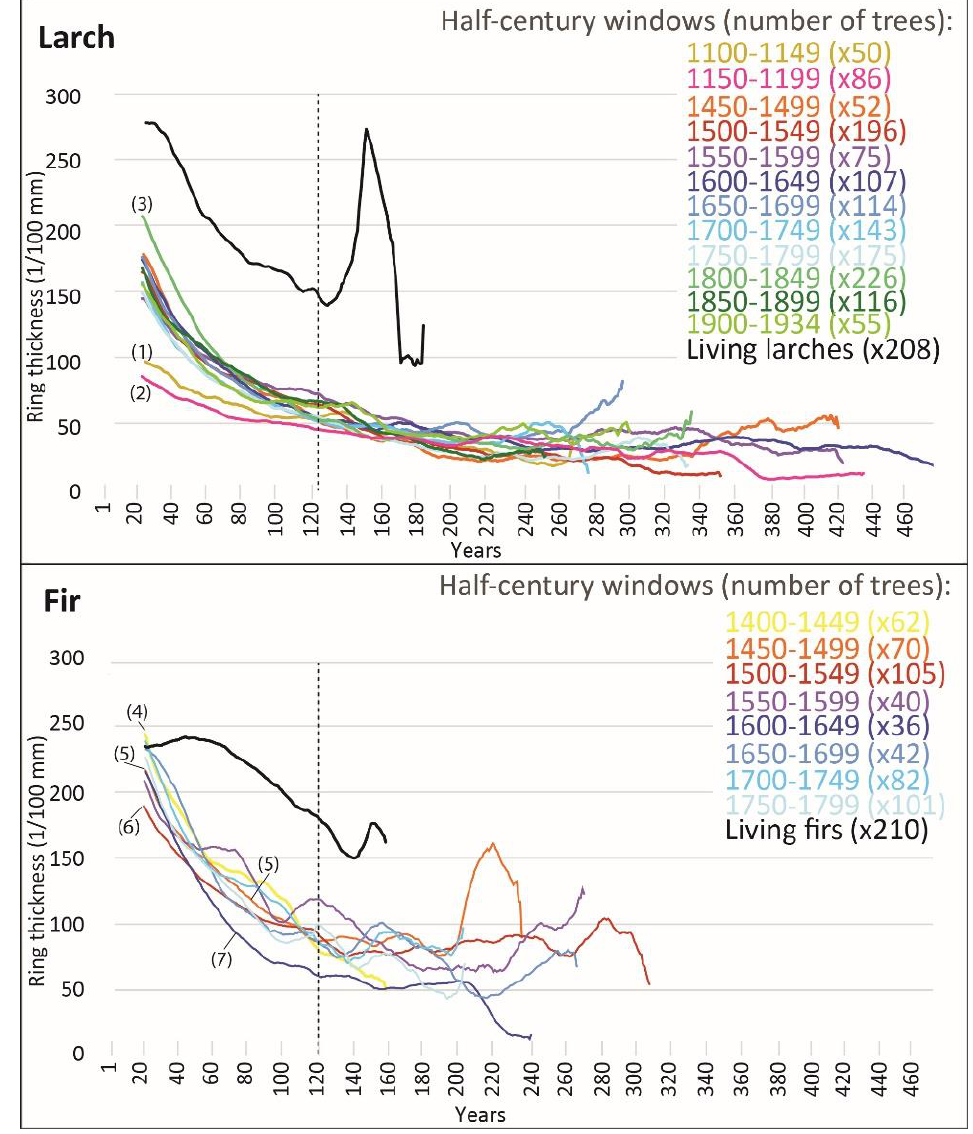
Figure 4. Age trends of archaeological larches (upper part) and firs (lower part) according to 50-year time windows, based on the date of their last ring, each in a different colour. The age trends of the actual trees are shown in black. After the 120th year (vertical dotted line), the age trends are less representative. The small numbers in brackets on the curves refer to explanations in the text.